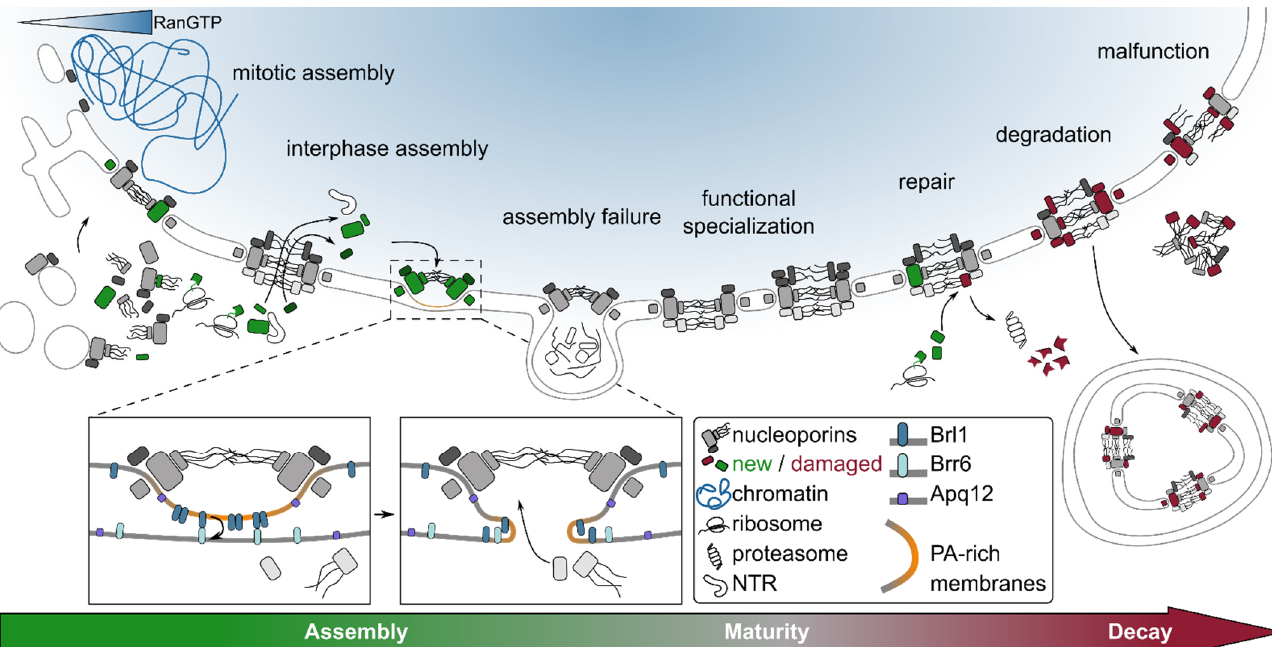
Figure 2. The lifecycle of the NPC. At the end of open mitosis, NUP recruitment to chromatin and membrane association is promoted through high local concentration of RanGTP. The NUPs seed the formation of NPCs by interacting with the re-forming NE. NPC assembly in interphase occurs “inside-out”—by inserting NPCs from the nuclear side into the sealed NE—and relies on the import of newly synthesized NUPs. It requires fusion of the inner and outer nuclear membranes by a poorly understood mechanism. The membrane fusion might involve phosphatidic acid (PA) rich membranes and the transmembrane proteins Brl1, Brr6, and Apq12 in budding yeast or torsin AAA+ ATPases in vertebrates. Cytoplasmic NUPs can join and complete NPC assembly only after successful membrane fusion. Failure in NPC assembly leads to stalled NPC intermediates (herniations) in the inner nuclear membrane enclosed by the NE and deprived of cytoplasmic NUPs. NPCs mature into compositionally and functionally different sub-populations, e.g., the budding yeast NPC can vary in the content of nuclear basket proteins or the number of nuclear Y rings. Damaged NPCs can be repaired in a “piecemeal” manner by proteasomal degradation of individual NUPs without the requirement for complete NPC disassembly. Entire NPCs can be degraded by the autophagy machinery. NPCs can accumulate damage in old age or disease, such as oxidative damage, loss of NUPs or phase-transition of FG NUPs in the cytoplasm, which leads to NPC malfunction and impaired transport. See text for details.